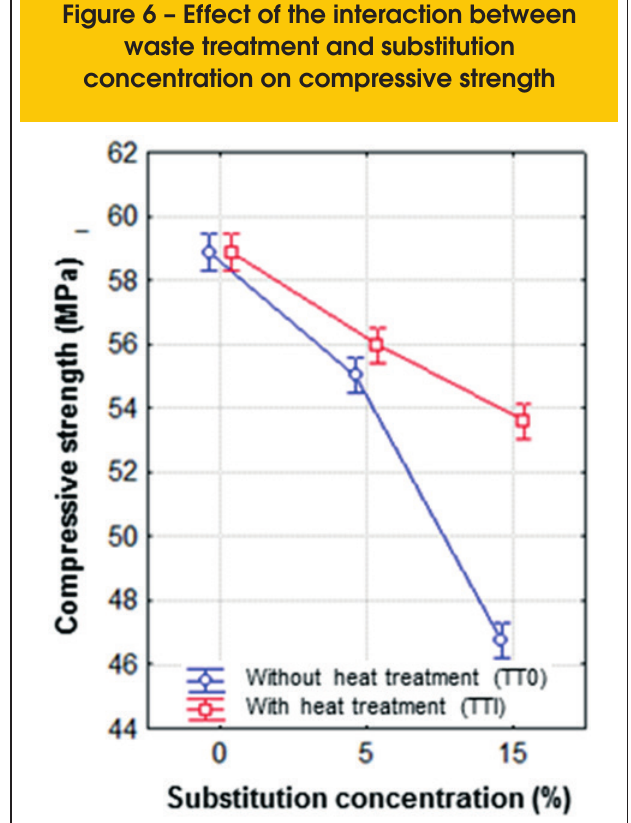
Figure 6 – Effect of the interaction between waste treatment and substitution concentration on compressive